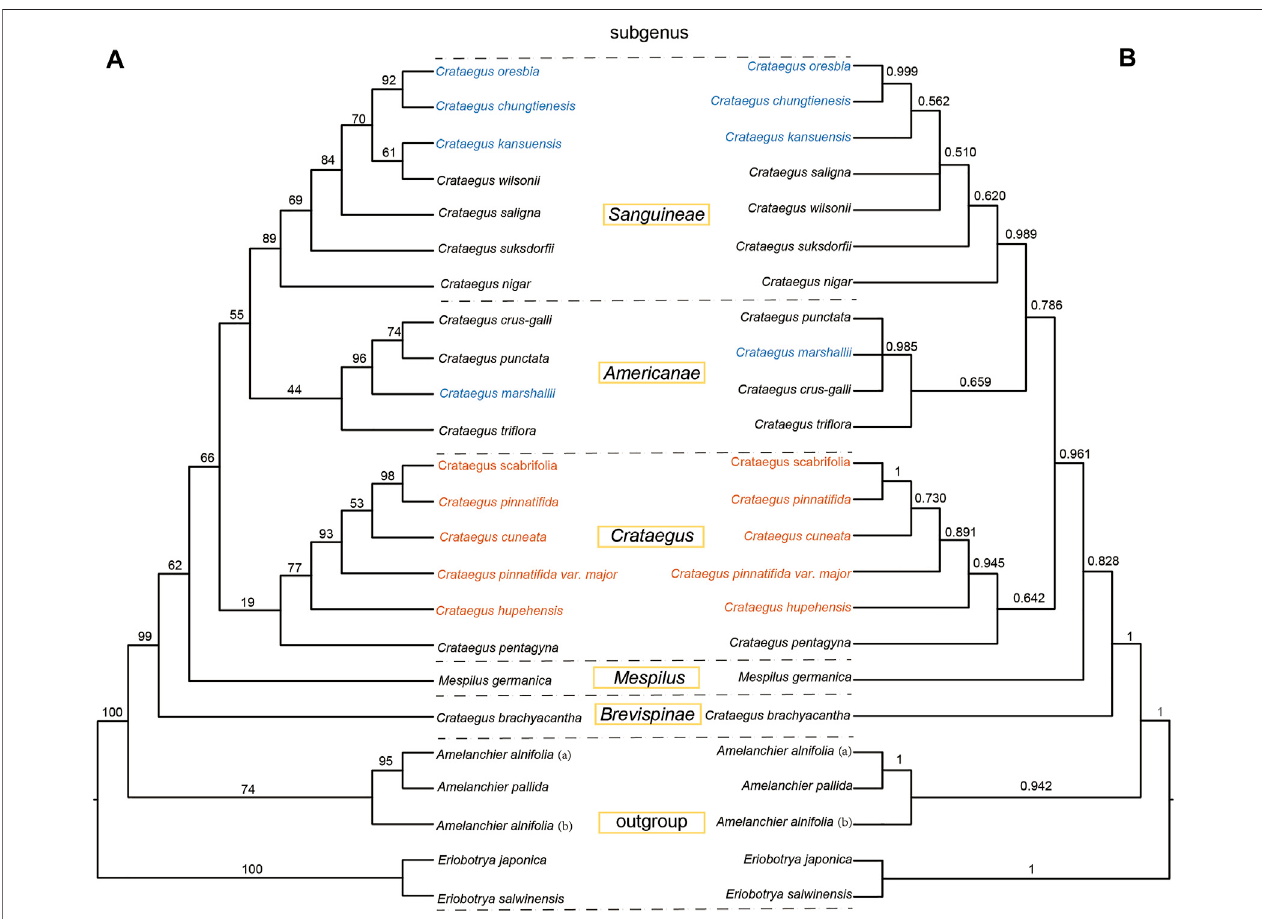
FIGURE 7 | Phylogenetic tree of Crataegus based on the sequences of fi ve intergenic regions. The different colors represent the different evolutionary branches clades(cladeAandcladeB)inthephylogenetictreeconstructedfromthecompletechloroplastgenome. (A) Phylogenetictreeconstructedbymaximumlikelihood(ML). (B) Phylogenetic tree constructed by maximum Bayesian method